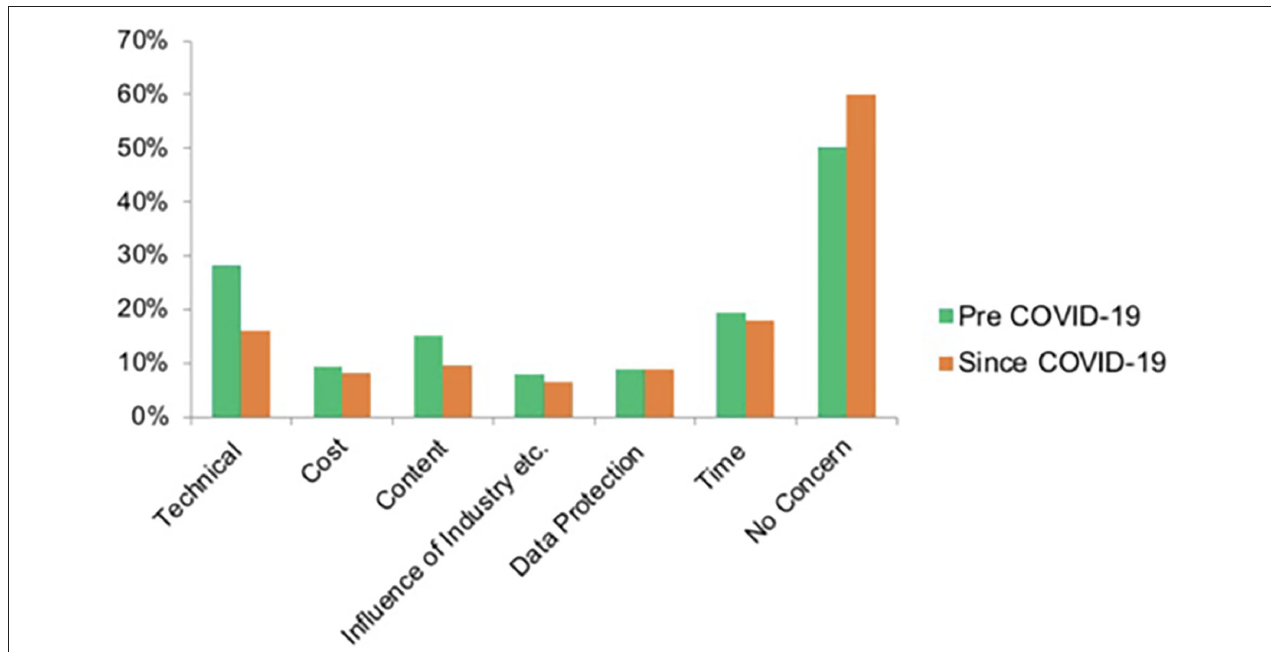
FIGURE 3 | Concerns of responders regarding online CME.